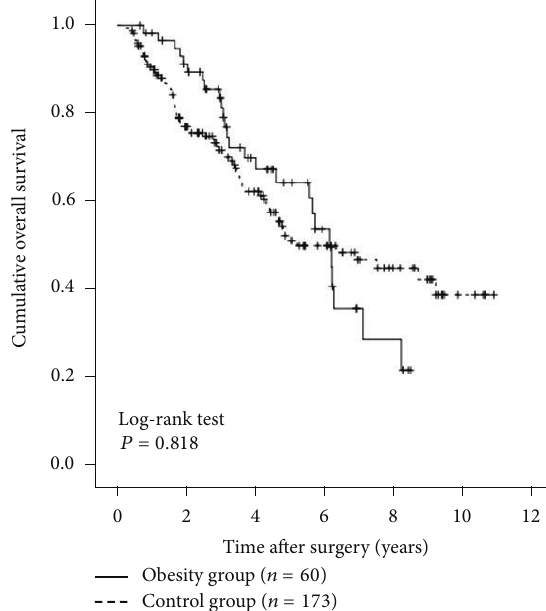
Figure 3: Cumulative recurrence-free survival (RFS) rates in the obesity group ( 𝑛 = 60 ) and the control group ( 𝑛 = 173 ). The 1-, 3-, and 5-year cumulative RFS rates were 70.1%, 27.0%, and 12.0%, respectively, in the obesity group and 70.1%, 39.0%, and 21.7%, respectively, in the control group ( 𝑃 = 0.124